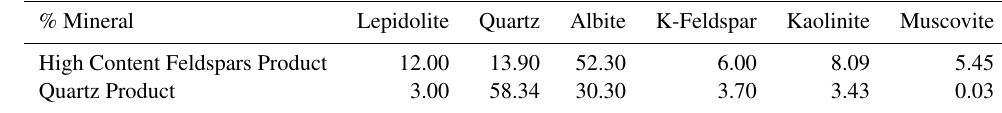
Table 3. Major elements analysis of the feldspars/quartz separation.